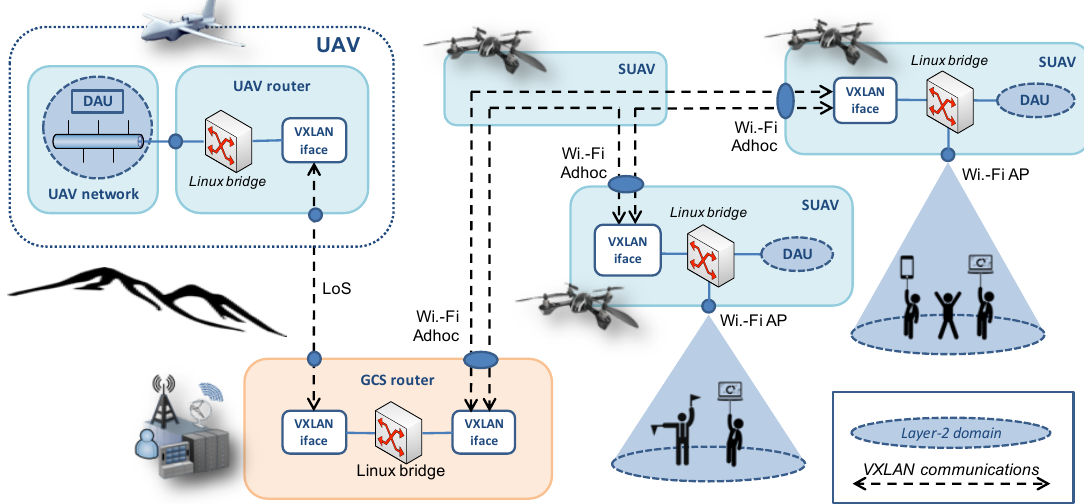
Figure 3. VXLAN and Linux bridge